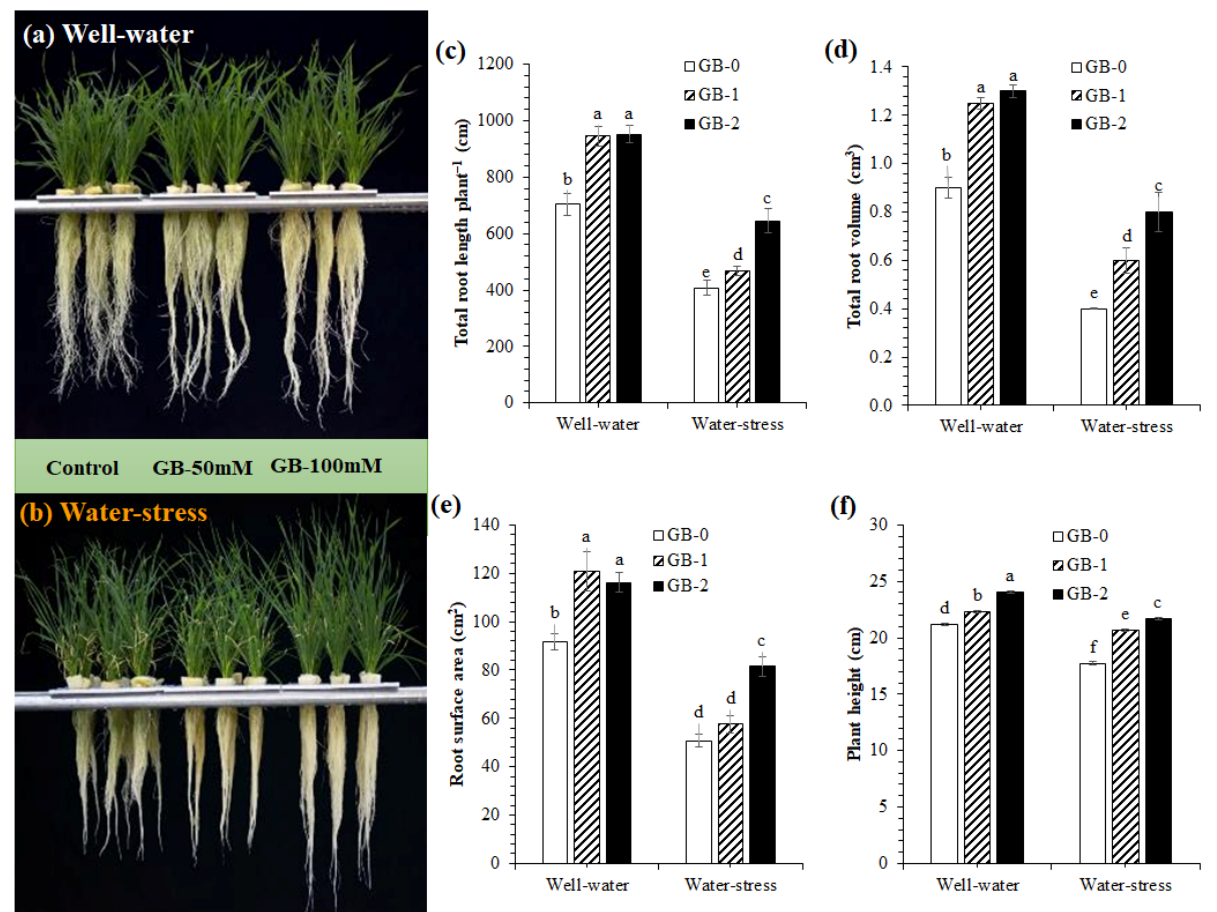
Figure 1. Effect of GB root-priming on wheat seedling morphological characteristics ( a , b ), root architecture (total root length ( c ), root volume ( d ), surface area ( e ) and shoot length ( f ) of wheat seedling grown under well-water and water-stress conditions. Each value represents the mean ± standard deviation (SD) of three replicates. Bars showing different letters represent the significant differences at p ≤ 0.05 as determined by LSD test.